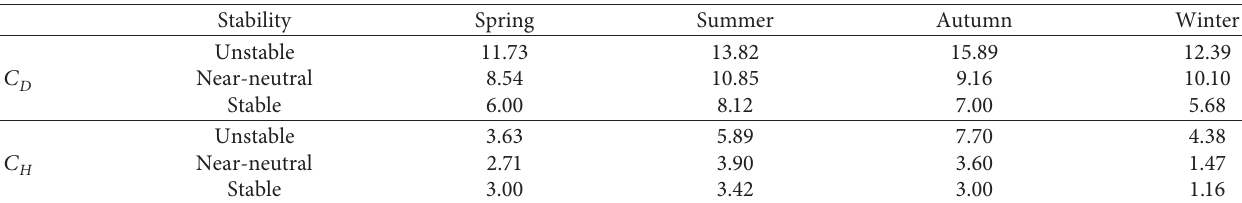
Table 5: Turbulent bulk transfer coefficients under different stability conditions and in different seasons ( × 10 − 3 ).